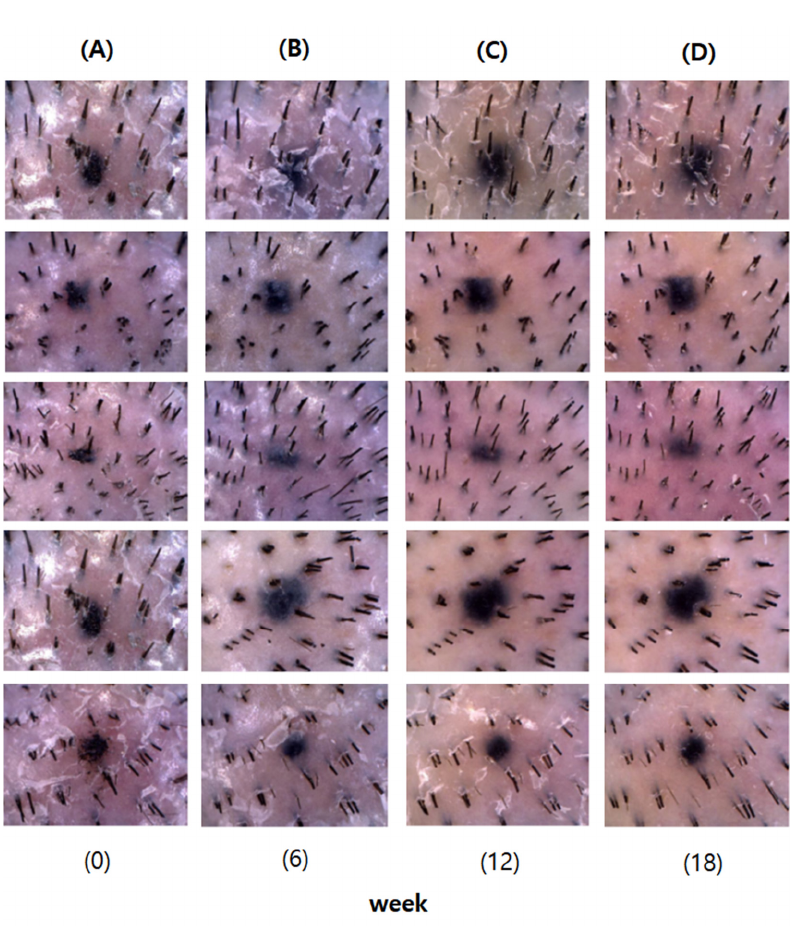
Figure 5. Five representative images obtained from using a phototricogram after 6, 12, and 18 weeks of use compared to before using the test products. Images are from ( A ) before using the products or after ( B ) 6 weeks, ( C ) 12 weeks, and ( D ) 18 weeks of using the test products (No. 9, 10, 11, 12, and 21).